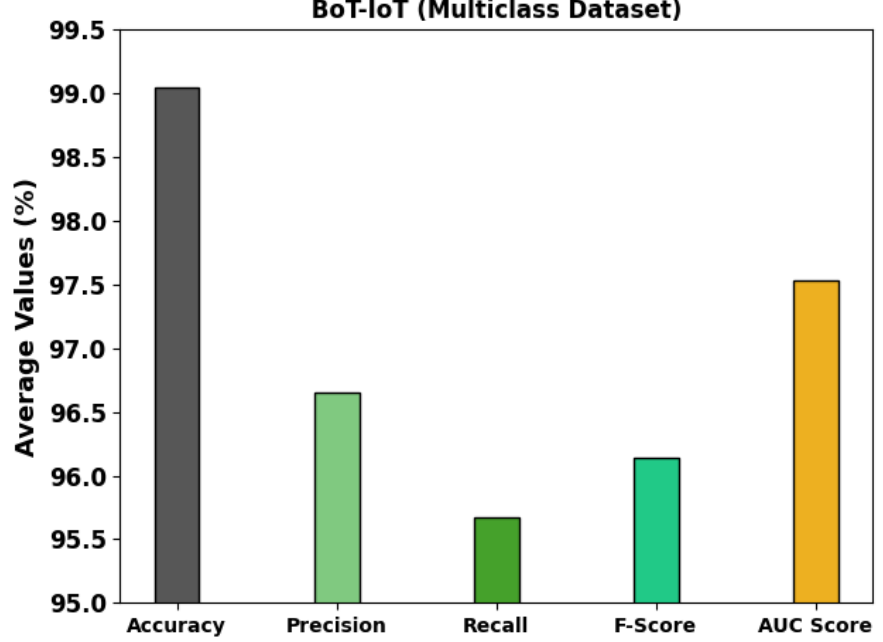
Figure 8. Average results of the H3SC-DLIDS approach on the multiclass dataset. Figure 9 exhibits the accuracy outcomes of the H3SC-DLIDS method during the training and validation processes using the multiclass dataset. The results represent the H3SC-DLIDS approach reaching high accuracy values with an increase in the number of epochs. Further, the increase in the validation accuracy values over training accuracy values demonstrates that the H3SC-DLIDS methodology learns the multiclass dataset